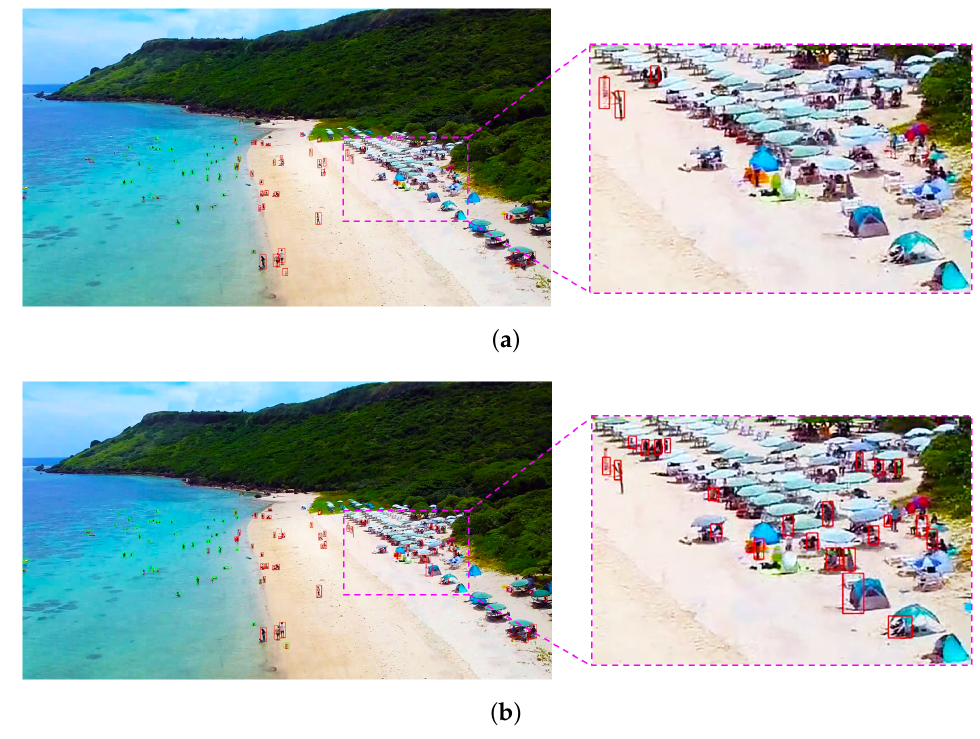
Figure 1. Intuitive examples on TinyPerson dataset [2] demonstrate the differences before and after the algorithmic improvements. ( a ) In the original YOLOv7 detection, many objects are missed in the enlarged detail. ( b ) This paper’s improved algorithm TOD-YOLOv7 can detect more